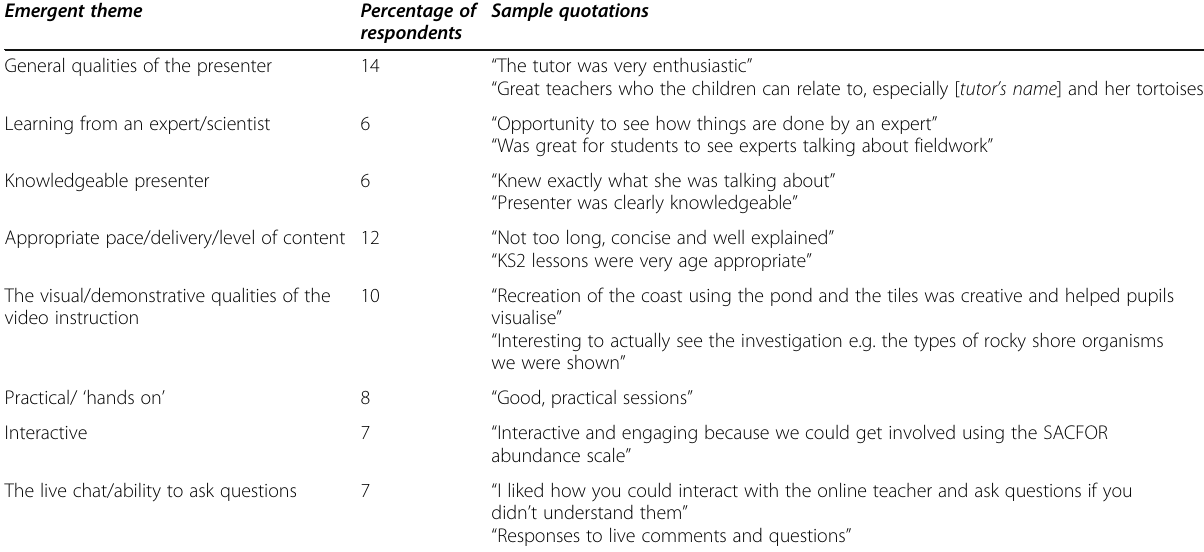
Table 2 Emergent themes in the content analysis for response data to the question: “ What did you like about the #FieldworkLive session ” ( n = 170). Only themes with > 5% respondents are shown